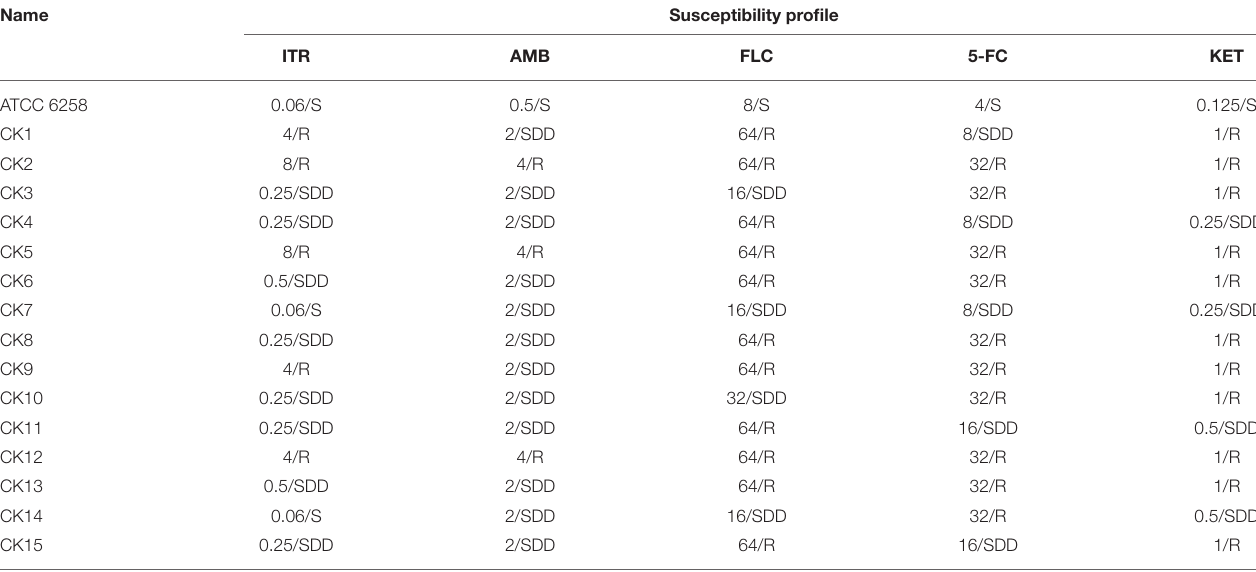
TABLE 1 | Minimal inhibitory concentration (MIC) and susceptibility profile of C. krusei clinical isolates ( n =